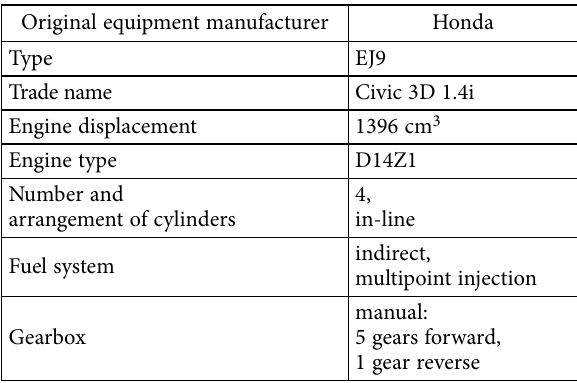
Table. Specifications of passenger car used in tests Original equipment